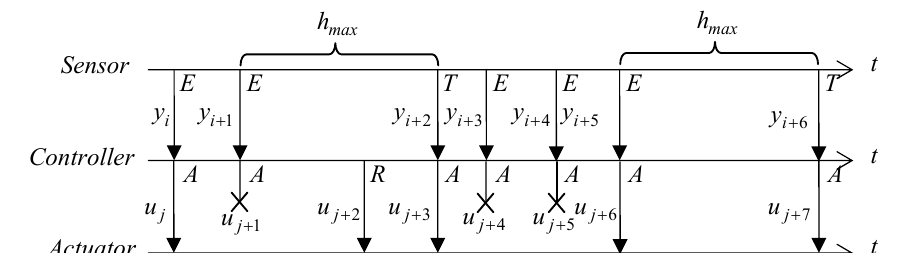
Figure 4. Exchange of information of the event-based approach including a simple send- on-delta strategy in the controller. The u | u − u | < ∆ u . The same situation happens with u j +1 j